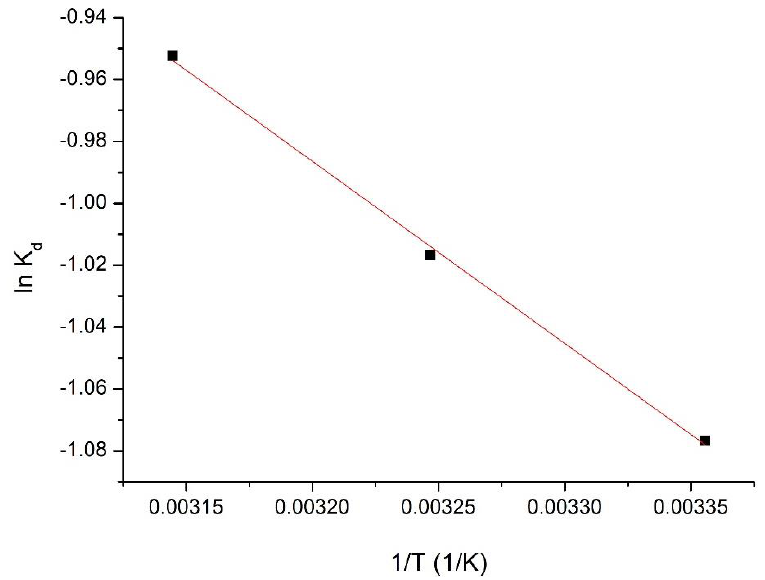
Figure 12. Thermodynamic studies for determination of ln K d vs. 1/T plot for SiO 2 FexOy sample. Table 5 presents the calculated thermodynamic parameters at all three temperatures.